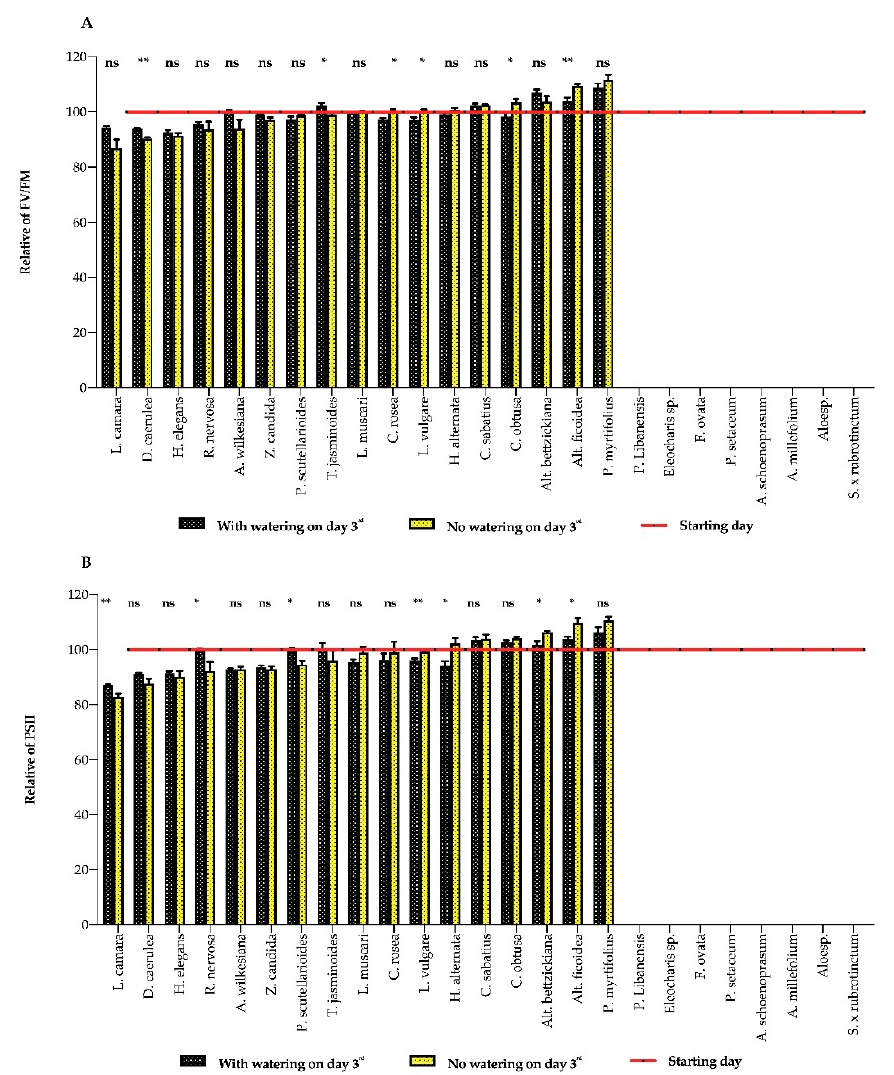
Figure 3. Effect of water deficiency on relative maximum quantum yield (Fv/Fm, A ) and maximum dark-adapted photochemichal efficiency of photosystem II (PSII, B ) on the 3rd day of the experiment for different plant species. Bars and error bars represeant mean ± SE. Non significant (ns) and significant differences (* at p < 0.05 and ** at p < 0.01 by Student’s T-test between no watering at 3 days are shown above the